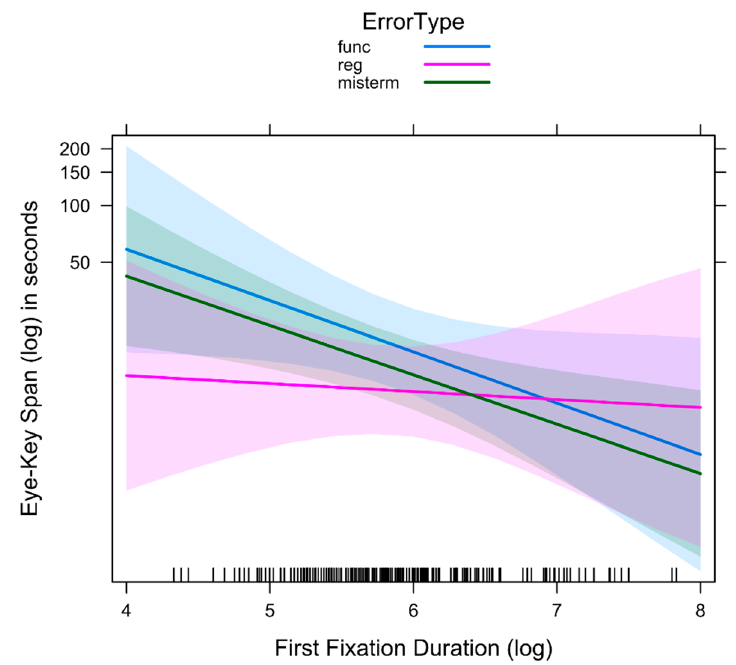
Figure 19. Interaction between log-transformed first fixation durations and Error Type for eye–key span (the time between first visual contact with a target word and the first keystroke that contributes to the correction of this token).